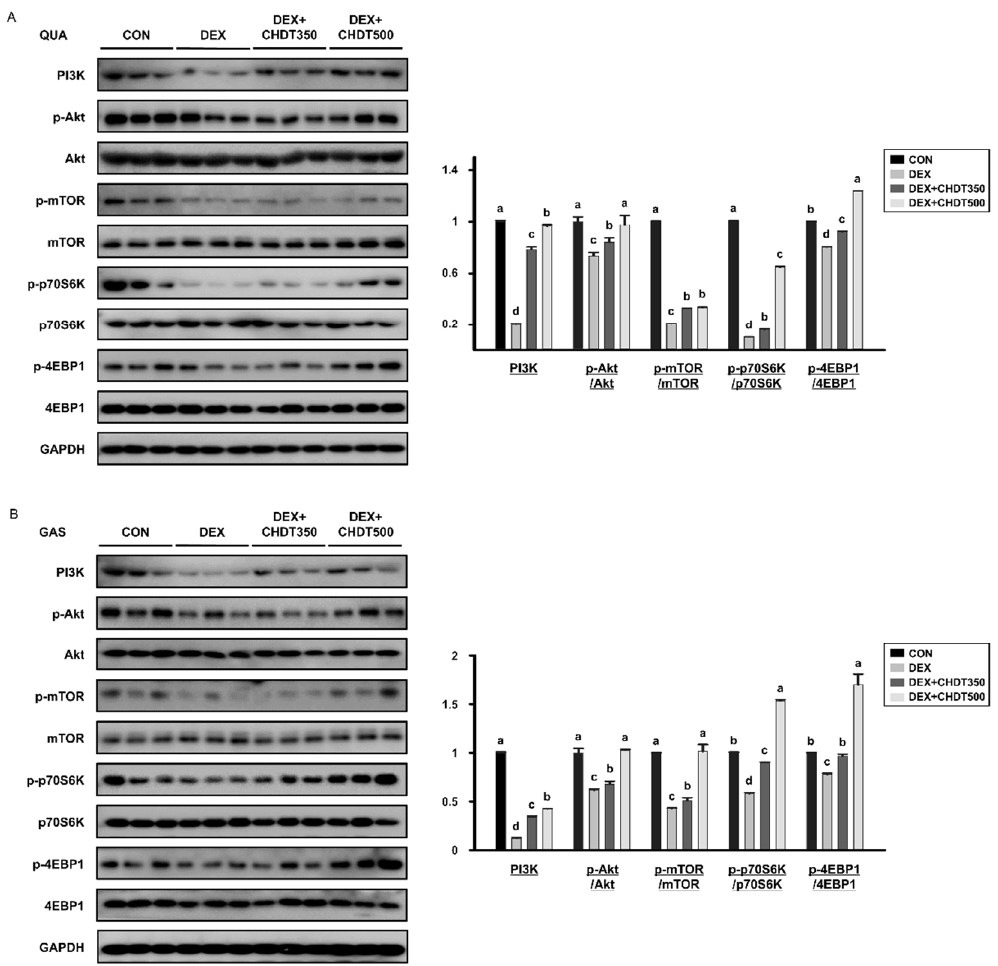
Figure 4. Effects of CHDT on the Akt/mTOR signaling pathway in mice with Dex-induced muscle atrophy. The protein expression levels of components of the Akt/mTOR signaling pathway were measured by Western blotting in ( A ) QUA and ( B ) GAS muscles. GAPDH was used as the loading control and the phosphorylation of the intermediates was normalized to the total expression levels of each protein. Different letters indicate statistically significant differences; p < 0.05, a > b > c >